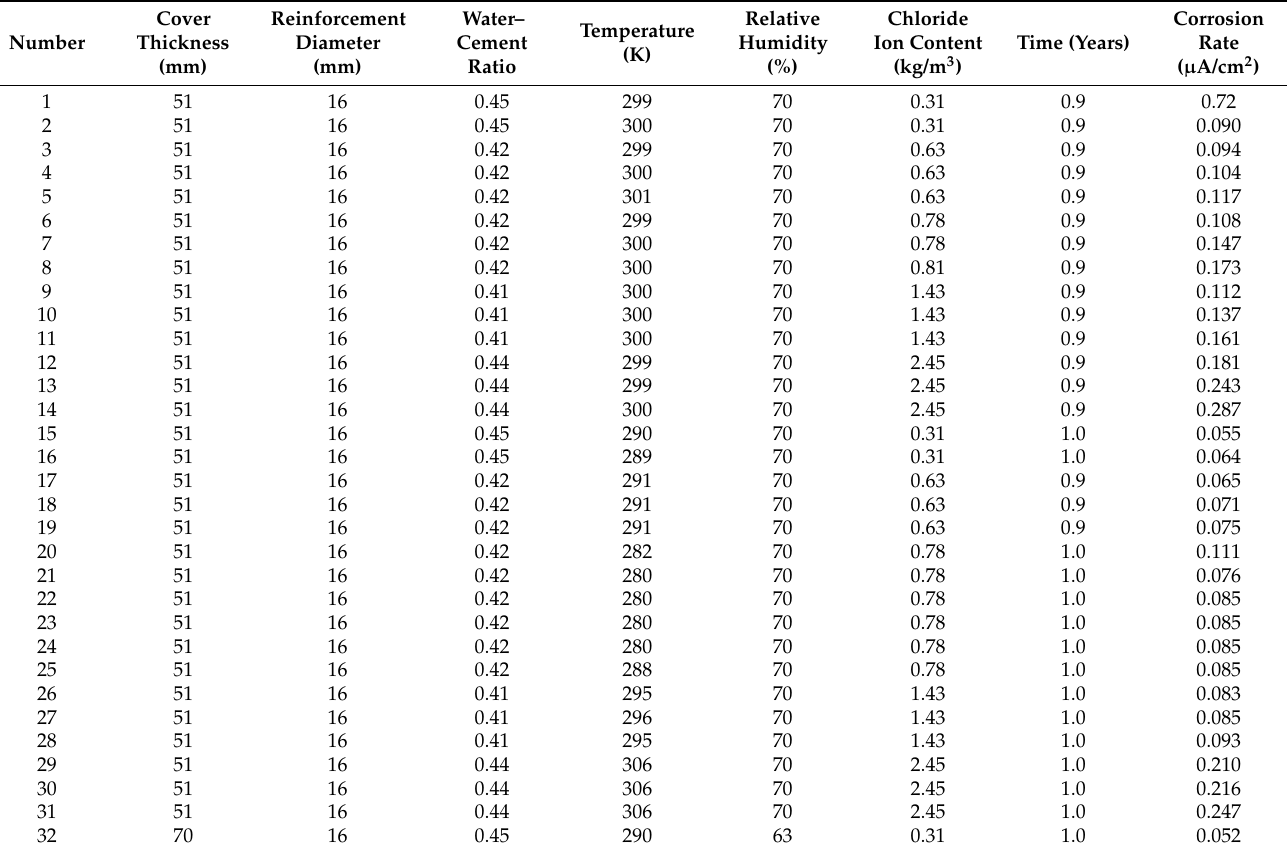
Table 2. Test data of corrosion rate of reinforcement caused by chloride